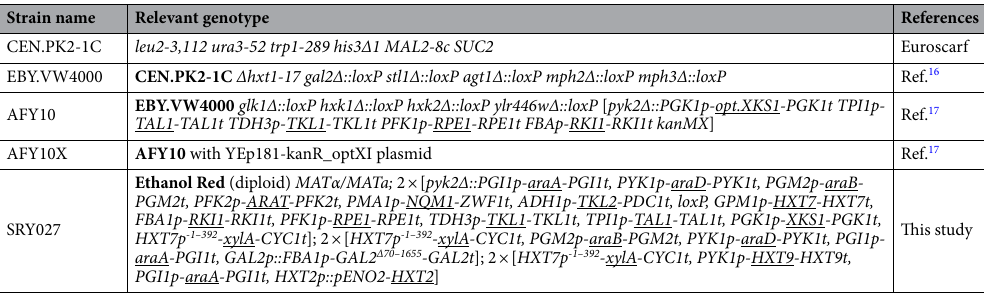
Table 1. Strains used in this study. The genotypes are annotated according to the standard nomenclature. Promoters and terminators are denoted by suffixes “p” and “t”, respectively. Overexpressed ORFs resulting in functional proteins are underlined. The integrated genetic cassettes are shown in brackets. The occurrence of two identical alleles in a diploid genome is indicated by “2×”. Gene deletions are indicated by a “Δ”, followed by the range of deleted amino acids, where appropriate. Parental strains are indicated in bold under “relevant